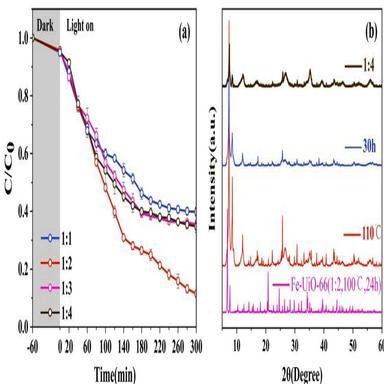
(a) Degradation of sulfameter with different Fe doping levels And (b) XRD patterns of materials prepared under various conditions.